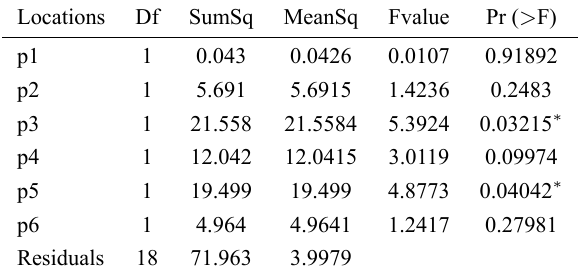
Table 2. ANOVA effect of wrestlers training experience on the location of weak links in low threshold tests.